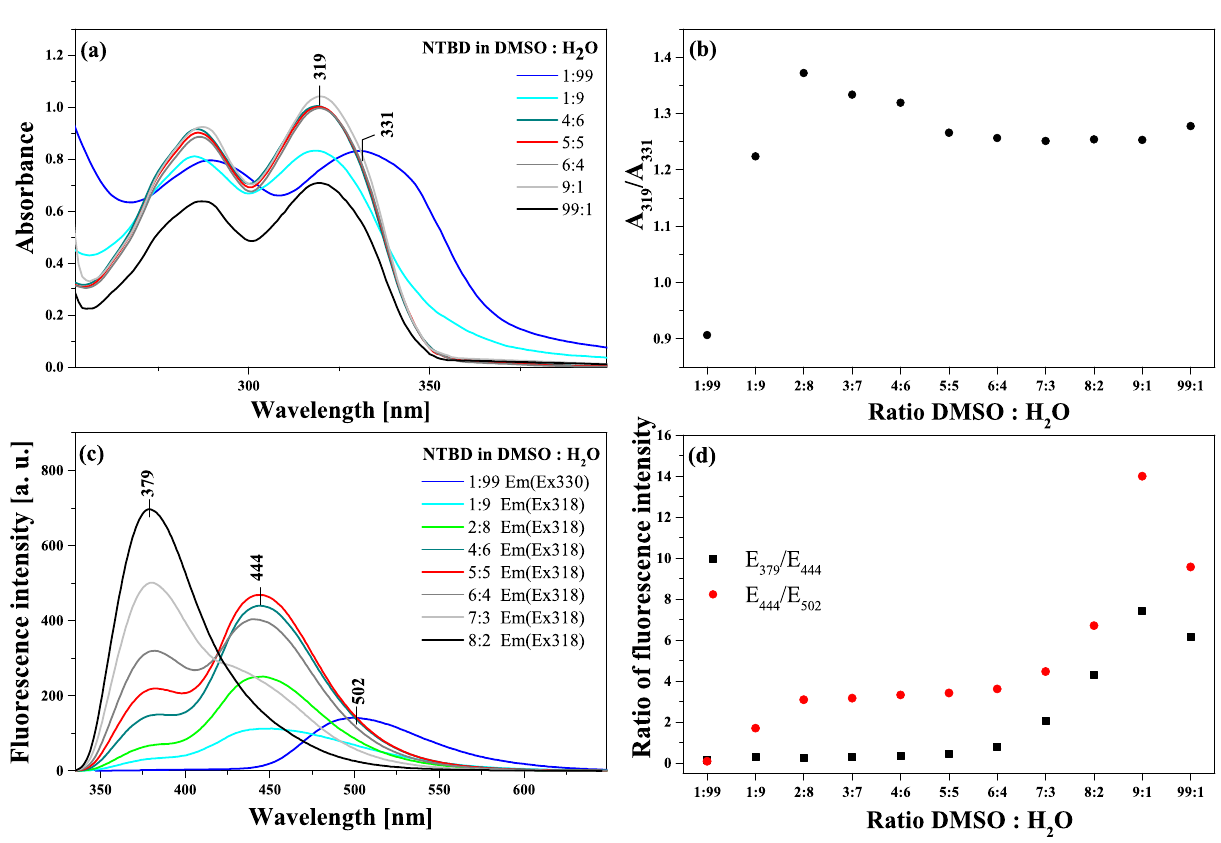
Figure 8. Panel ( a ): Absorption spectra of NTBD in DMSO: H 2 O solutions with various – 1:99, 1:9, 4:6, 5:5, 6:4, 9:1 and 99:1 – volume ratio. Panel ( b ): Correlation between the ratio of absorbance at the wavelength of 319 nm to the one at 331 nm and the ratio of DMSO to H 2 O in mixed solution. Panel ( c ): Fluorescence emission spectra of NTBD in DMSO: H 2 O solutions with various – 1:99, 1:9, 2:8, 4:6, 5:5, 6:4, 7:3 and 8:2 – volume ratio. The excitation was set at the absorbance maximum of each sample, respectively as pointed in the figure. Panel ( d ): Correlation between the ratio of fluorescence emission at the wavelength of 379 nm to the one at 444 nm along with the ones at 444 nm to 502 nm and the ratio of DMSO to H 2 O in mixed solution. The experiments were conducted at room